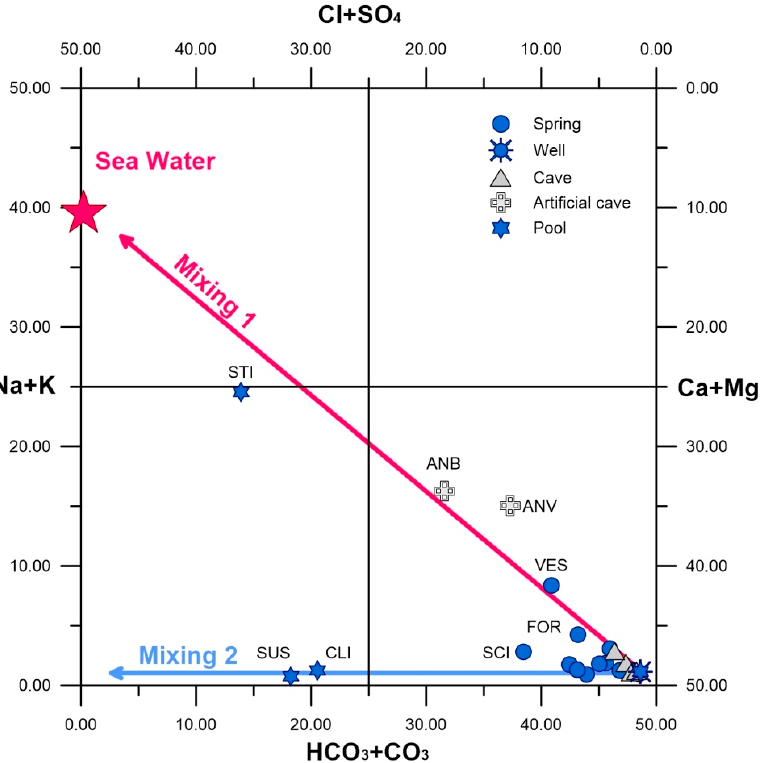
Figure 2. Langelier–Ludwig diagram showing the geochemical classification of the sampled waters. Water 2020 , 12 , x